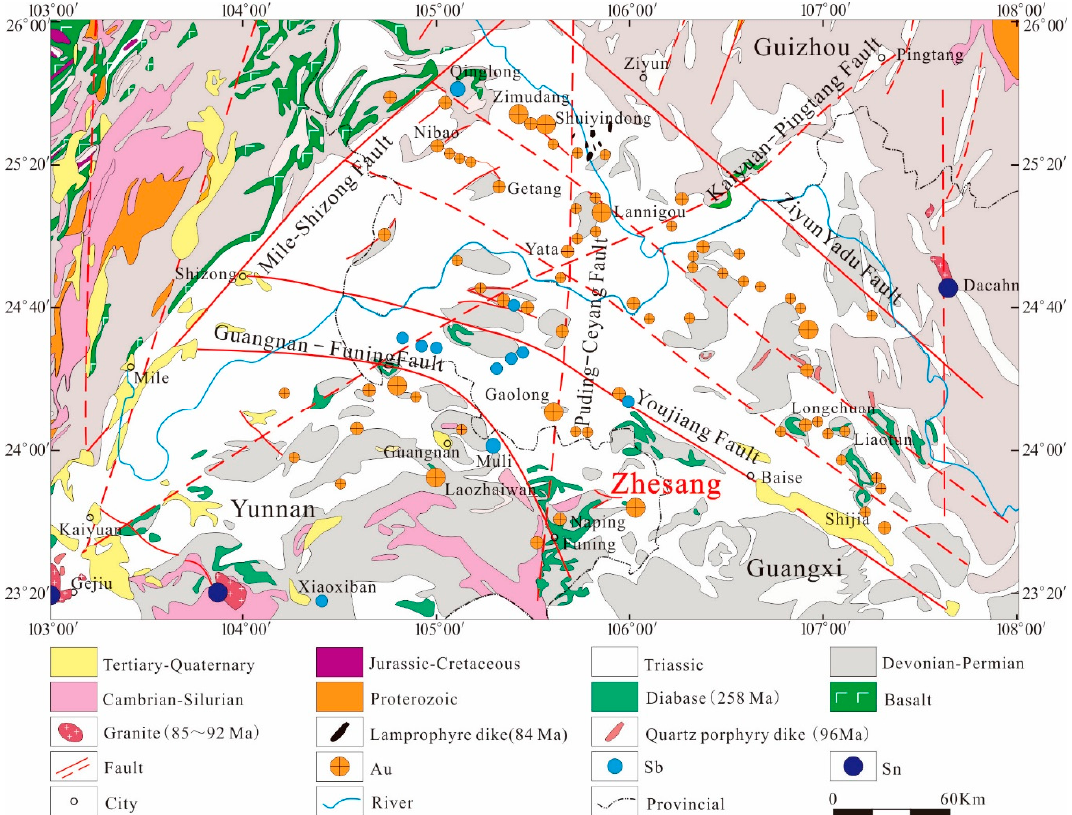
Figure 1. Geologic map of the large-scale, low-temperature epithermal metallogenic domain in southwestern China, showing the locations of Carlin-like gold, antimony, and tin-polymetallic deposits in the Youjiang basin [7].